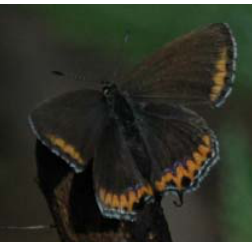
(under)Image 16. White-bordered Copper, Lycaena pavana